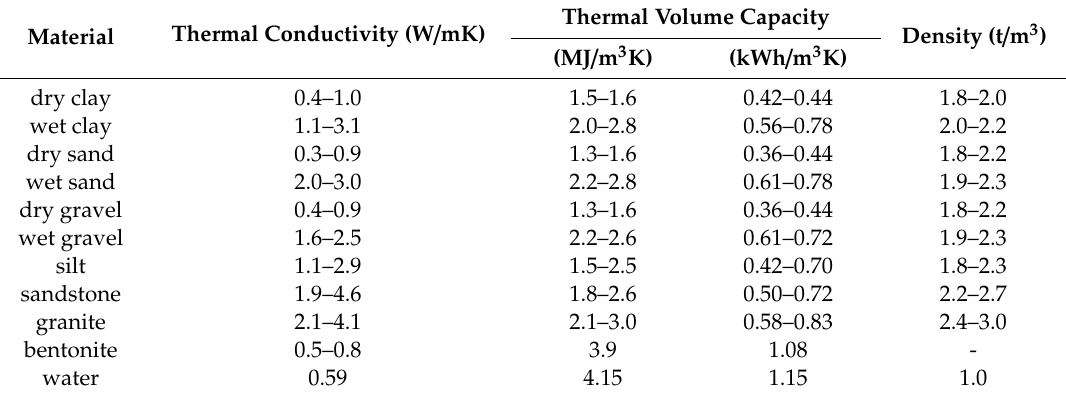
Table 7. Thermal properties of raw materials [45].